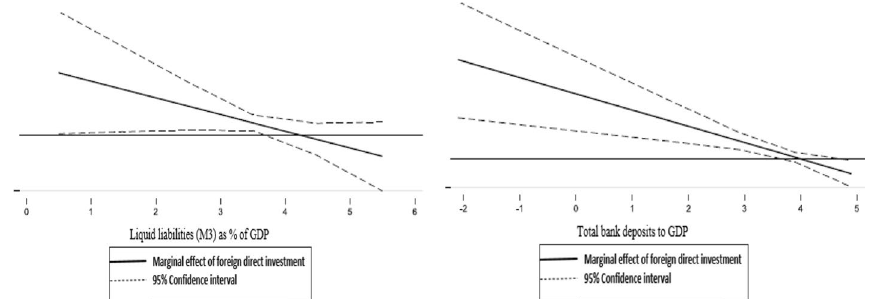
Fig. 12 Effects of foreign direct investment inflows on CO 2 emissions as financial development changes. Dependent variable: